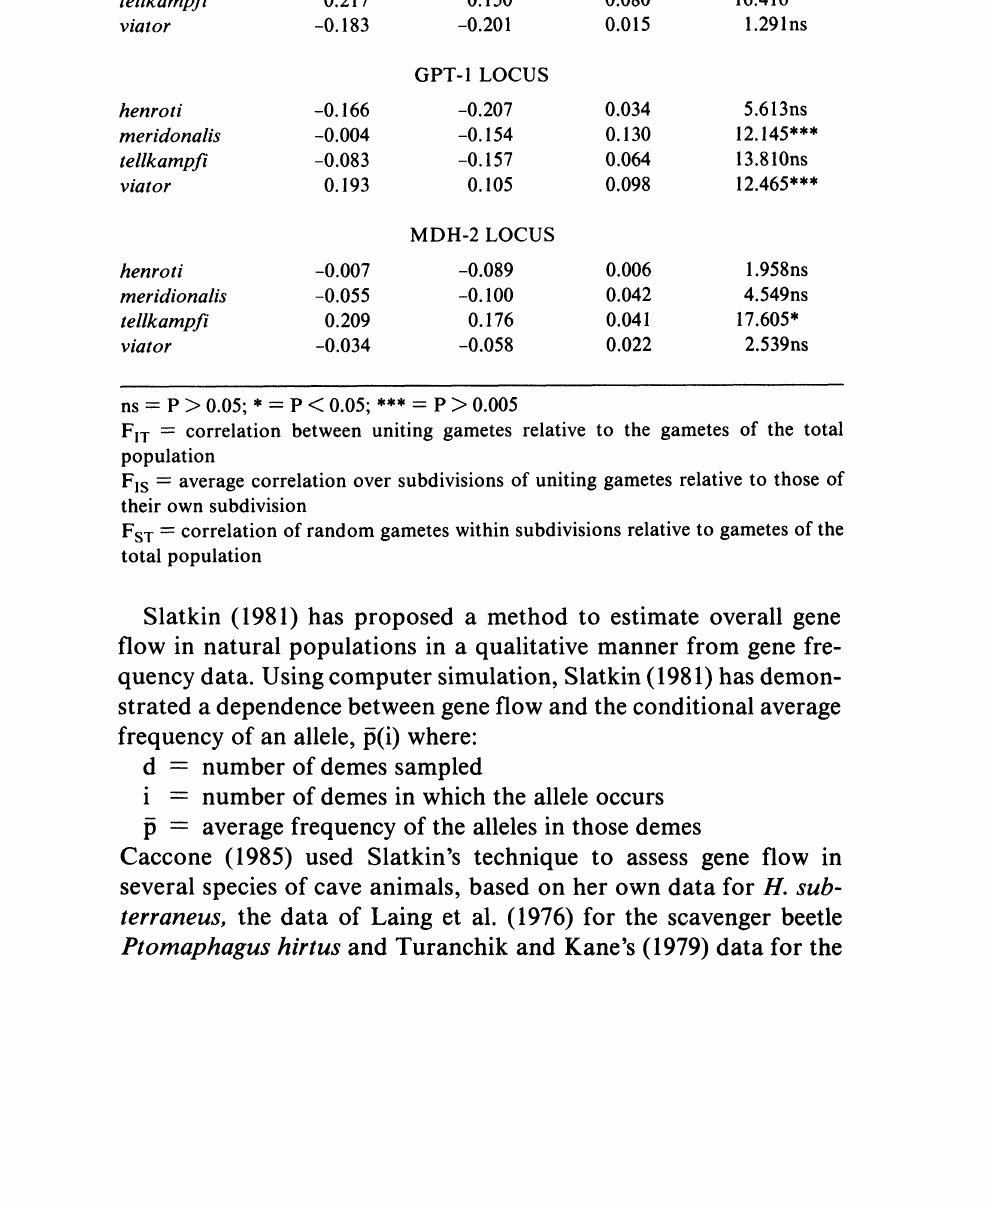
Table 4. F-statistics and heterogeneity chi-square values for four subspecies of N.